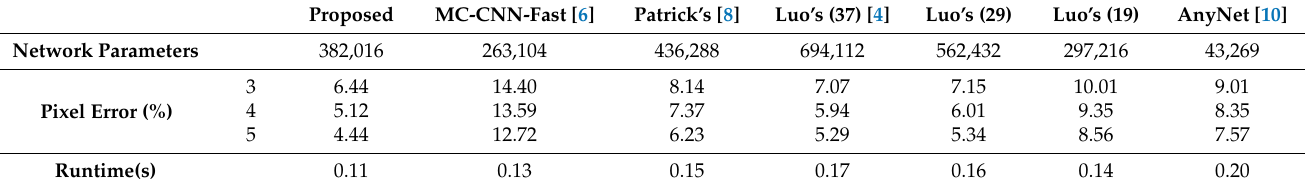
Table 1. Comparison of N-pixel errors, total parameters, and runtime(s) on the KITTI 2015 validation